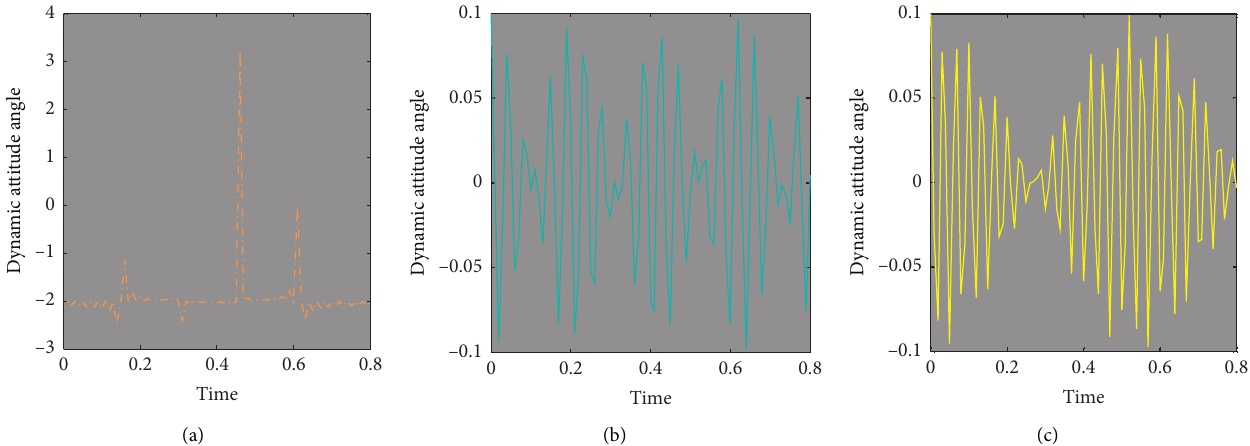
Figure 9: Calculation results of the motion pose capture method: dynamic attitude angle of (a) Z axis, (b) Y axis, and (c) X axis.